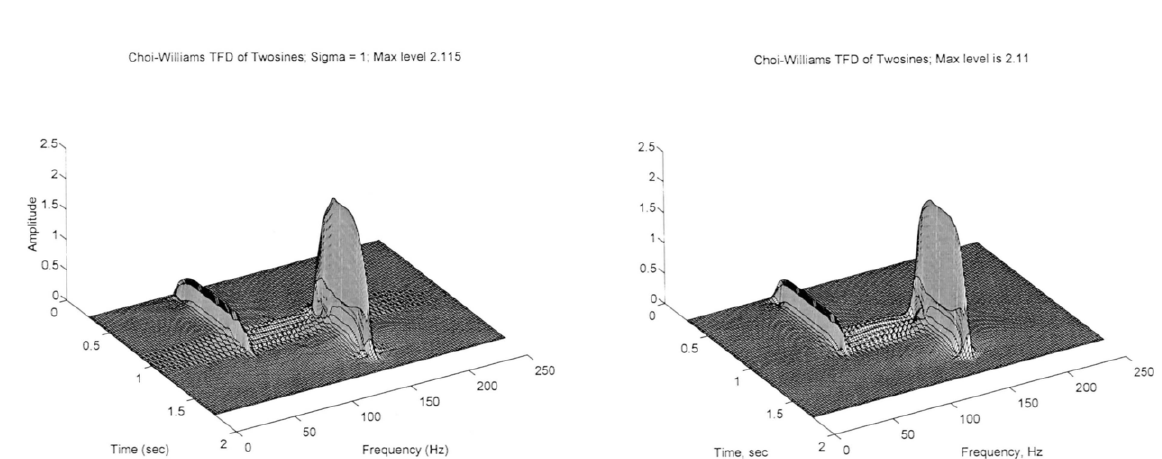
FIGURE 6 Choi-Williams distribution for Twosines with (J' =